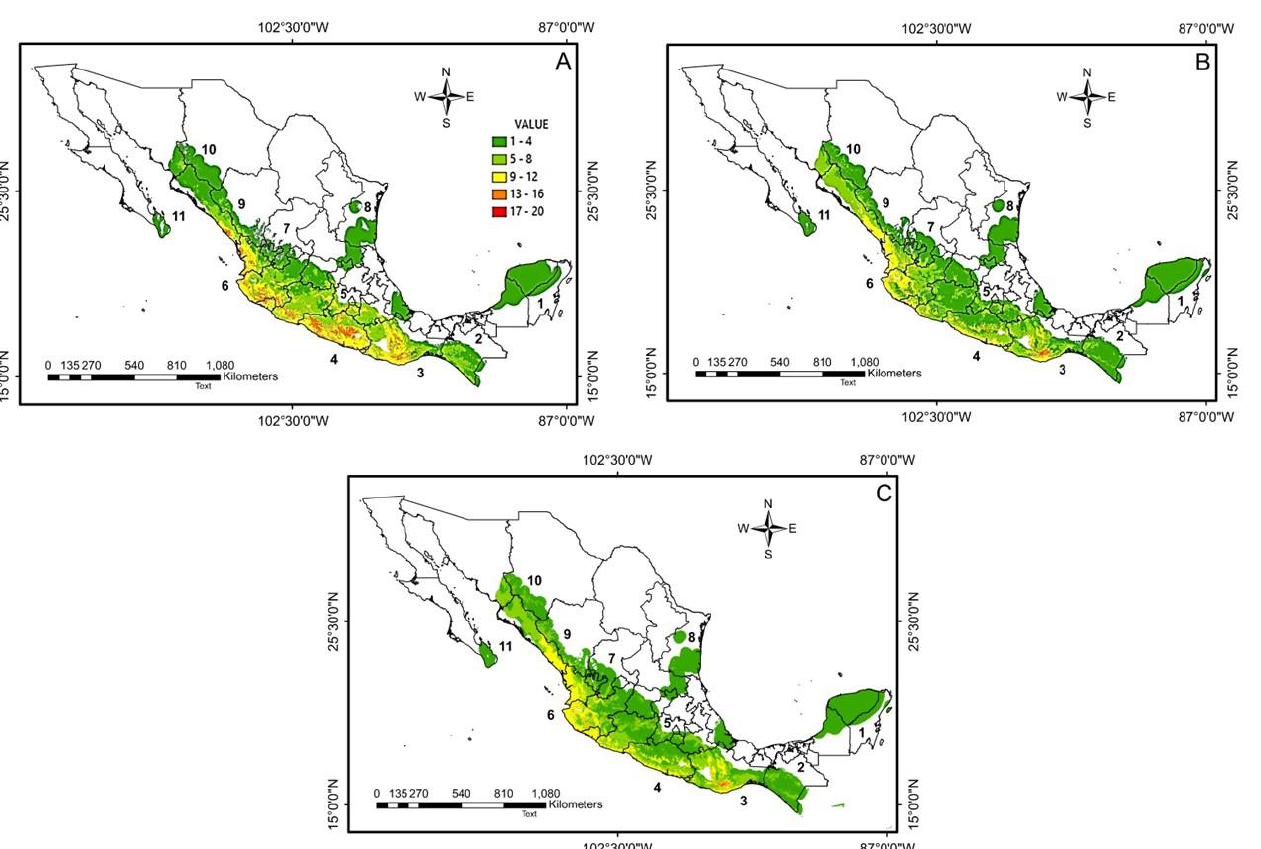
Figure 4. Differences in rate of range change (%) between the two Representative Concentration Pathways (RCPs), dots represent those species that will increase their area more than the average. 4. Discussion We are currently in the sixth mass extinction period caused by factors such as climate change, land use change, the overexploitation of natural resources, pollution, and intro- duced species [11]. Although climate change is one of the greatest topics of interest today, its study is complicated due to the global scale on which it is presented, as well as the impossibility of determining a single future climate change scenario. The species that are